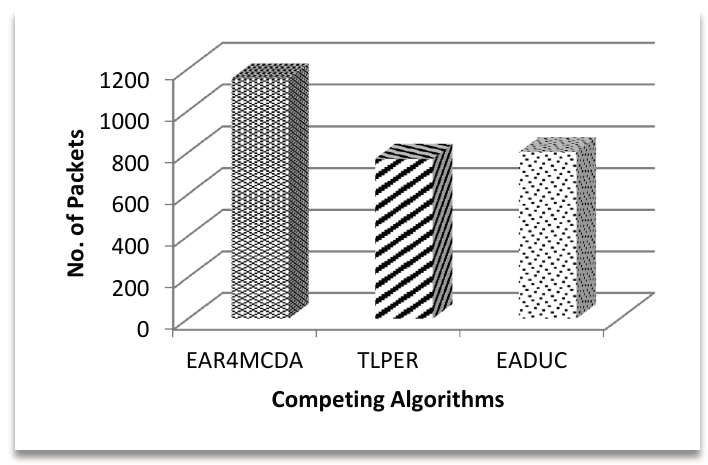
Figure 12. No. of packets produced in the first 60 s after cluster formation.